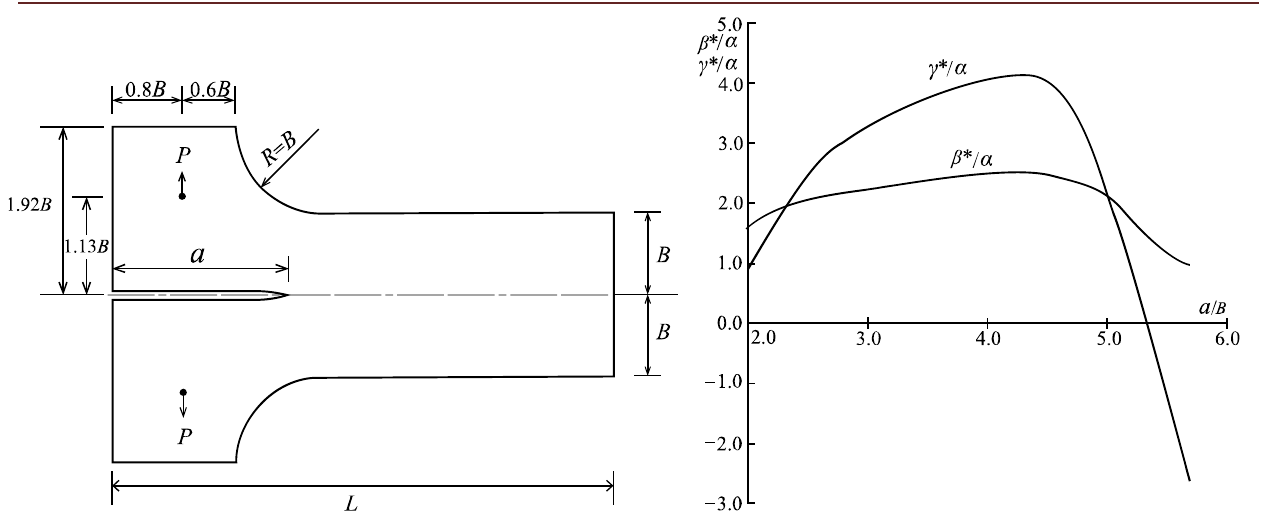
Figure 5: Double-cantilever beam specimen [12, 24]. Figure 6: Stability parameters for a double-cantilever beam specimen [12, 24].